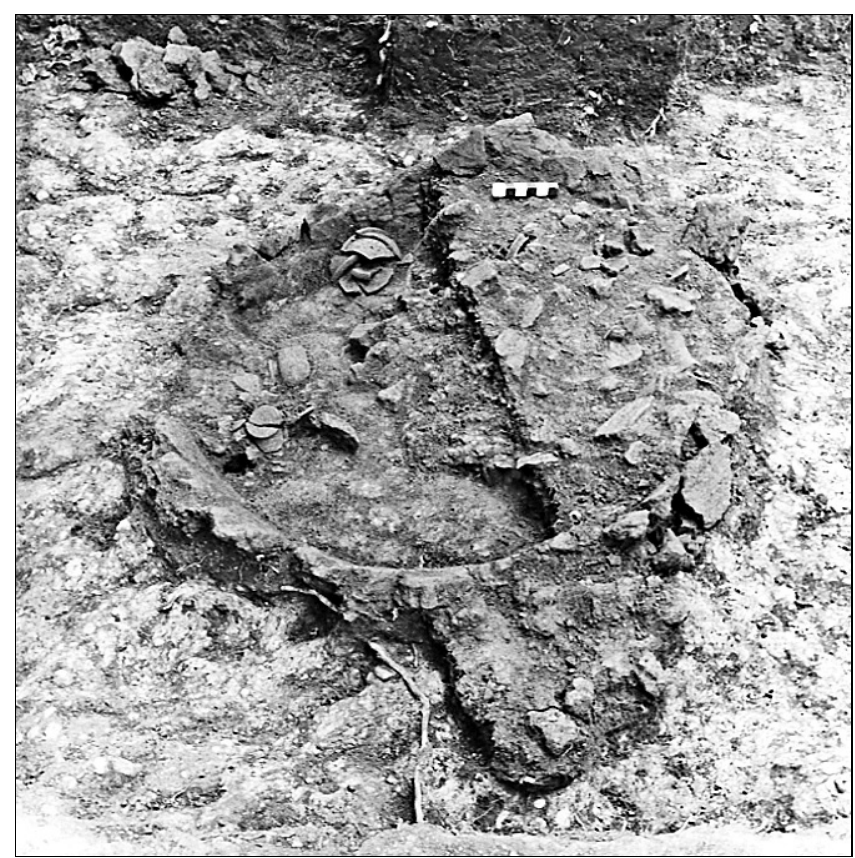
Figure 3 Kiln 3 under excavation at Highgate Wood in 1968; it has been sectioned and half the contents removed, leaving two complete but broken vessels in situ (scale bar 6